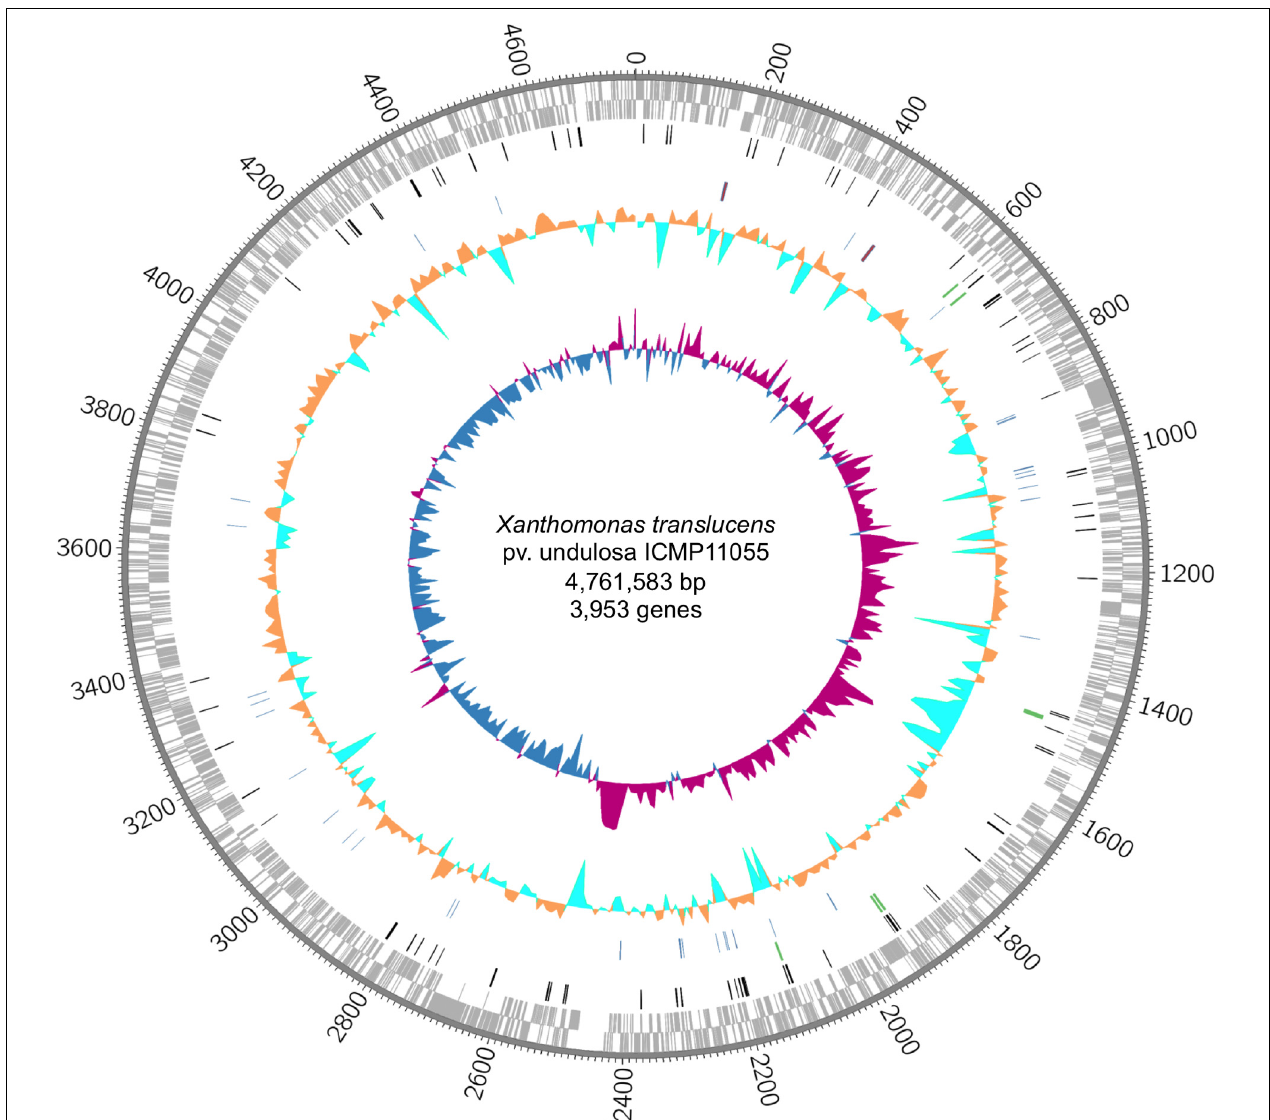
FIGURE 1 | The Xanthomonas translucens pv. undulosa ICMP11055 genome. Rings, outermost to innermost, illustrate coordinates (kb), protein-coding genes on the forward (outer) and reverse strands, IS elements (black), tal genes (green), tRNA (blue) and rRNA (red) genes, percent GC content, and GC skew. GC skew illustrates (G–C)/(G+C) in 10 kb windows; positive values indicate the leading strand of replication, and negative values indicate the lagging